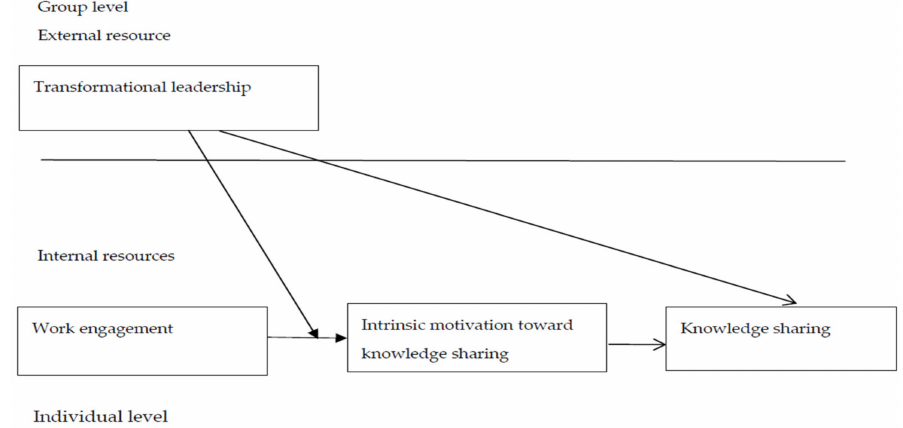
Figure 1. Research